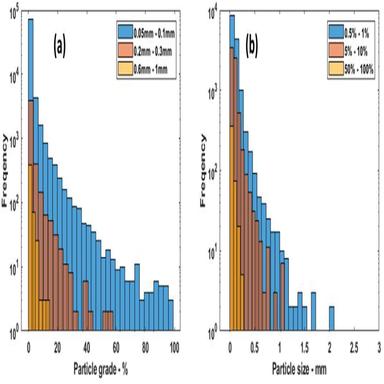
(a) Particle grade distribution for particles from 3 sizes, 0.05 mm-0.1 mm, 0.2 mm-0.3 mm and 0.6 mm-1 mm. (b) Particle size distribution for particles from 3 grade categories, 0.5 %-1%, 5 %-10 % and 50 %-100 %.